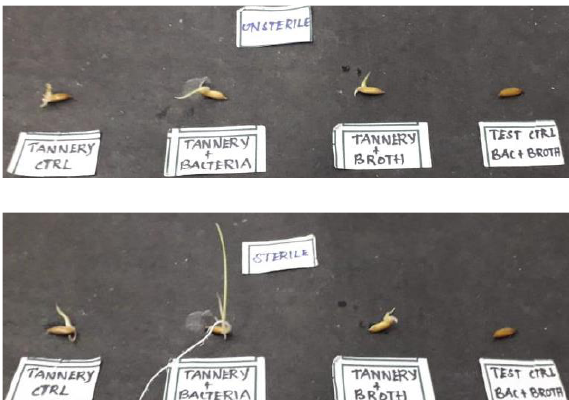
Figure 2. Microscopic view of Enterobacter sp. (40X)